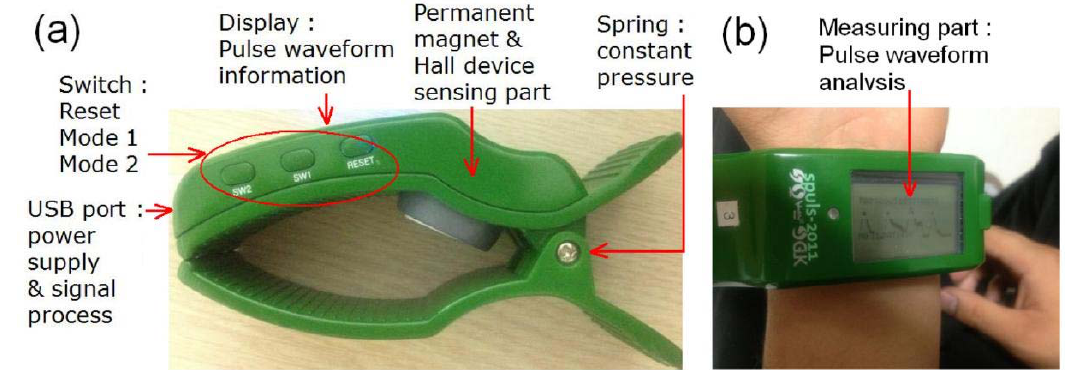
Figure 1. ( a ) The notation and function of several major parts and ( b ) the measurement process of acquisition pulse signals by a real clip-type